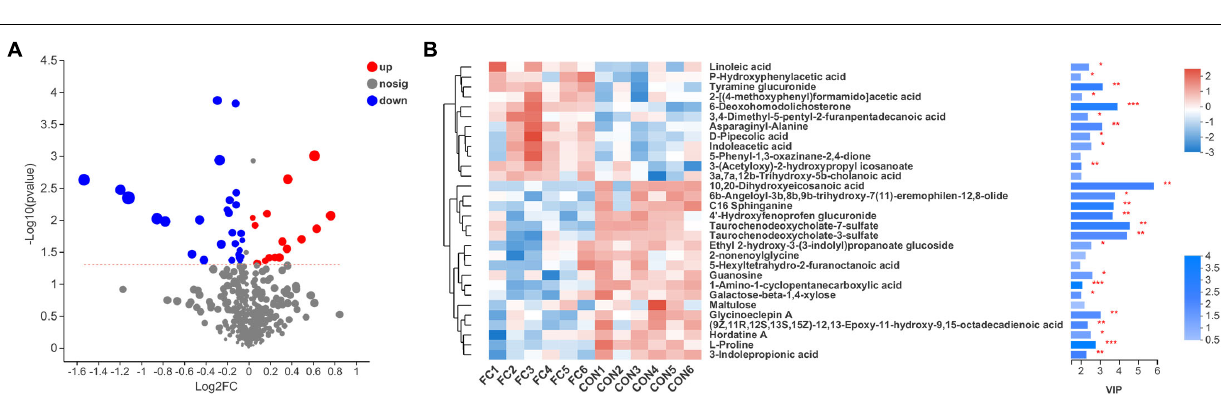
FIGURE 6 | Serum metabolite profiles of ewes with follicular cyst or normal follicle. (A) Enhanced Volcano plots of OPLS-DA showing fold changes (log 2 FC) and the negative logarithm (base 10) of the P -values of 44 differential serum metabolites in follicular cyst ewes compared with normal follicle ewes. (B) Expression profile, VIP score, and P- value of the top 30 differential serum metabolites in follicular cyst ewes compared with normal follicle ewes. *Significant difference in serum metabolome between ewes with follicular cyst and normal follicle ( P < 0.05), **significant difference ( P < 0.01), and ***significant difference ( P <